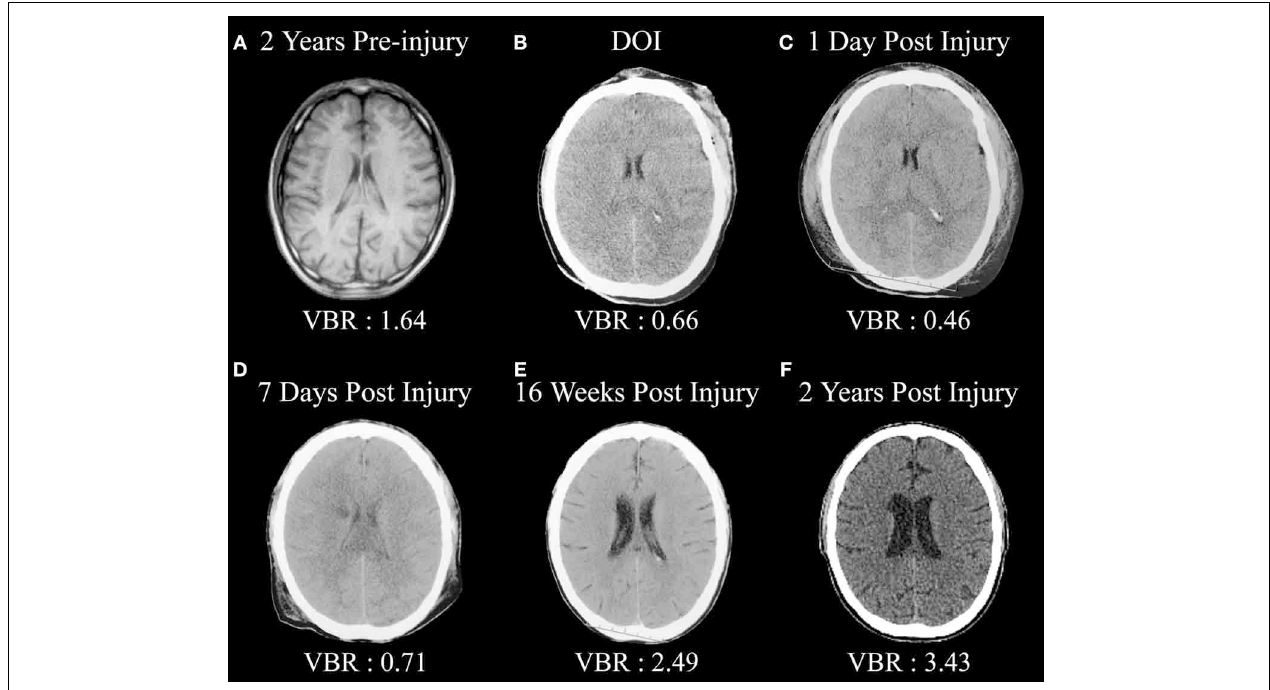
FIGURE 1 | (A) Pre-injury magnetic resonance image (MRI) approximately 2 years prior to a severe traumatic brain injury (TBI). Note the normal size of the ventricular system and ventricle-to-brain (VBR) ratio of 1.64 (normal is approximately 1.5 with a 0.5 standard deviation). (B) Day-of-injury initial CT